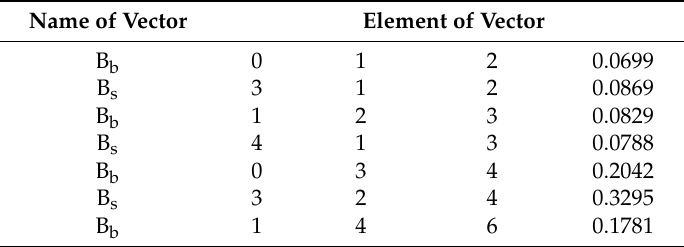
Table 2. The 2-D table corresponding to the curve in Figure 4.